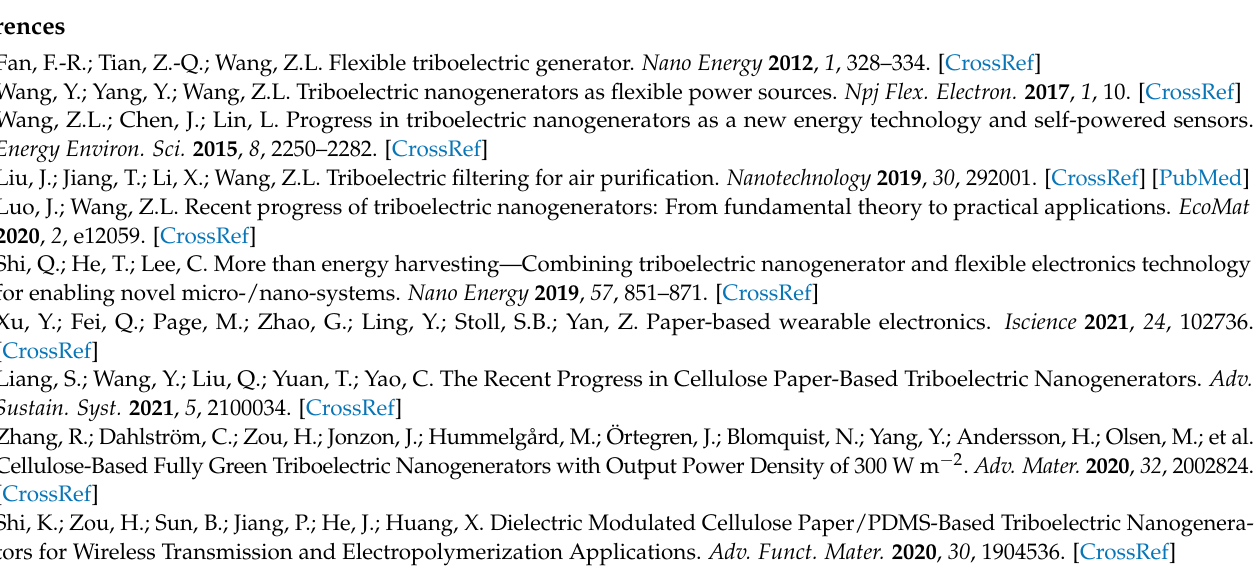
F4; Figure S2: The magnified XRD patterns at 2 θ in the range of 30–40 ◦